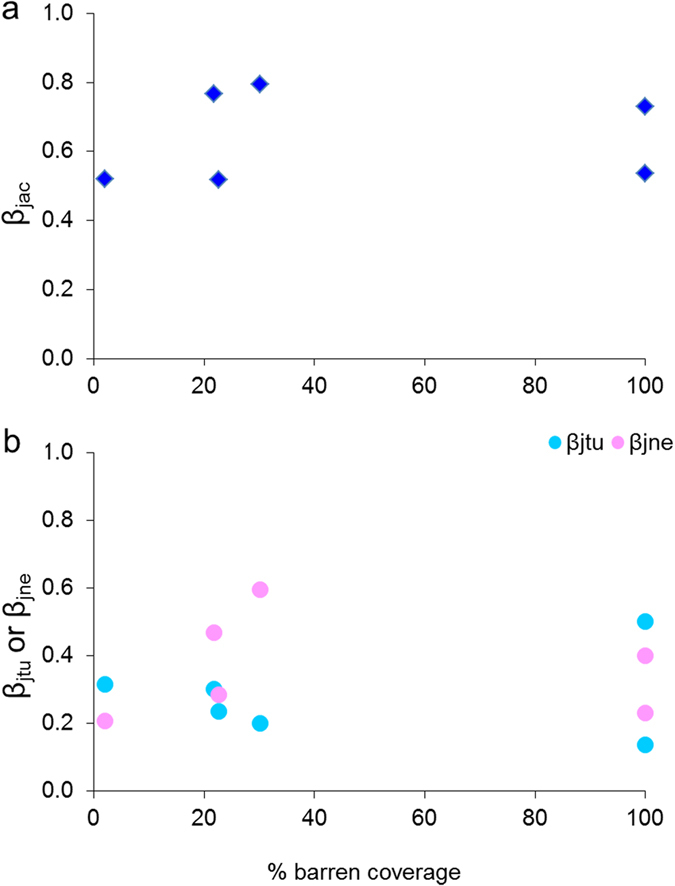
Relationships between % of barren coverage and β-diversity measures.(a) Jaccard β-diversity (βjac) and (b) turnover (βjtu) and loss of species (βjne) β-diversity components.